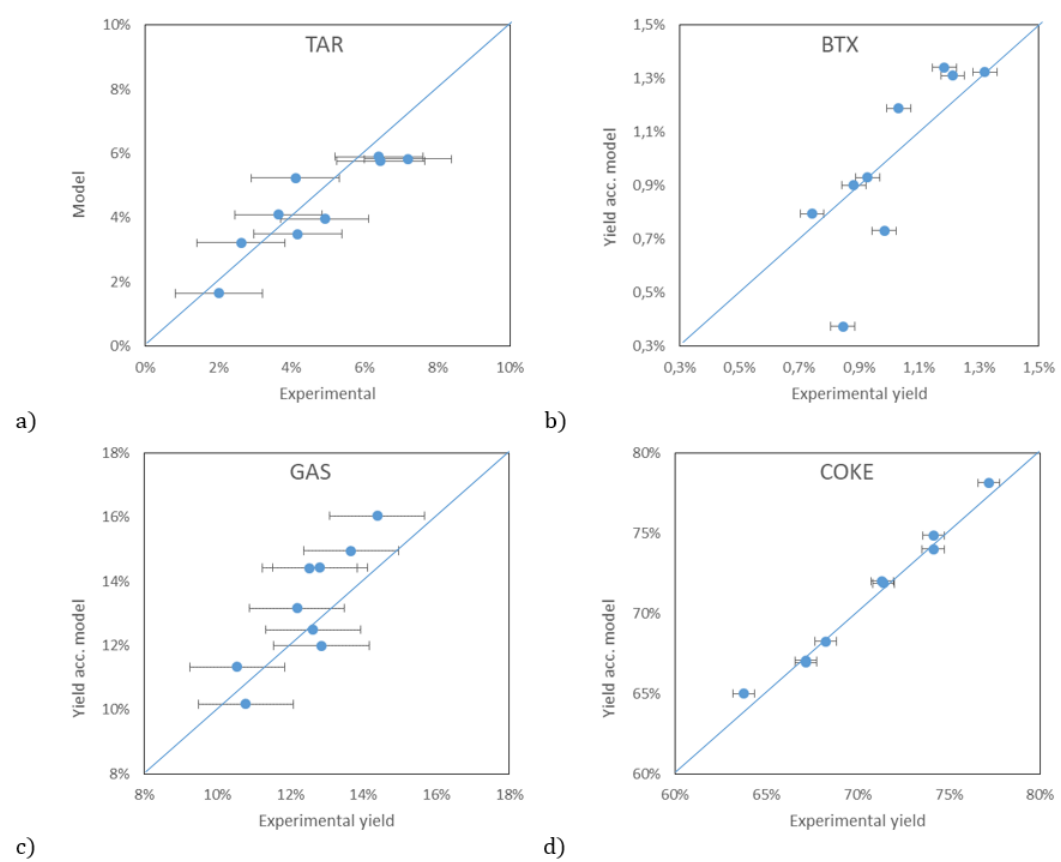
Figure 2. Model yields vs. experimental results yields of: ( a ) tar, ( b ) BTX, ( c ) coke oven gas, and ( d ) coke.